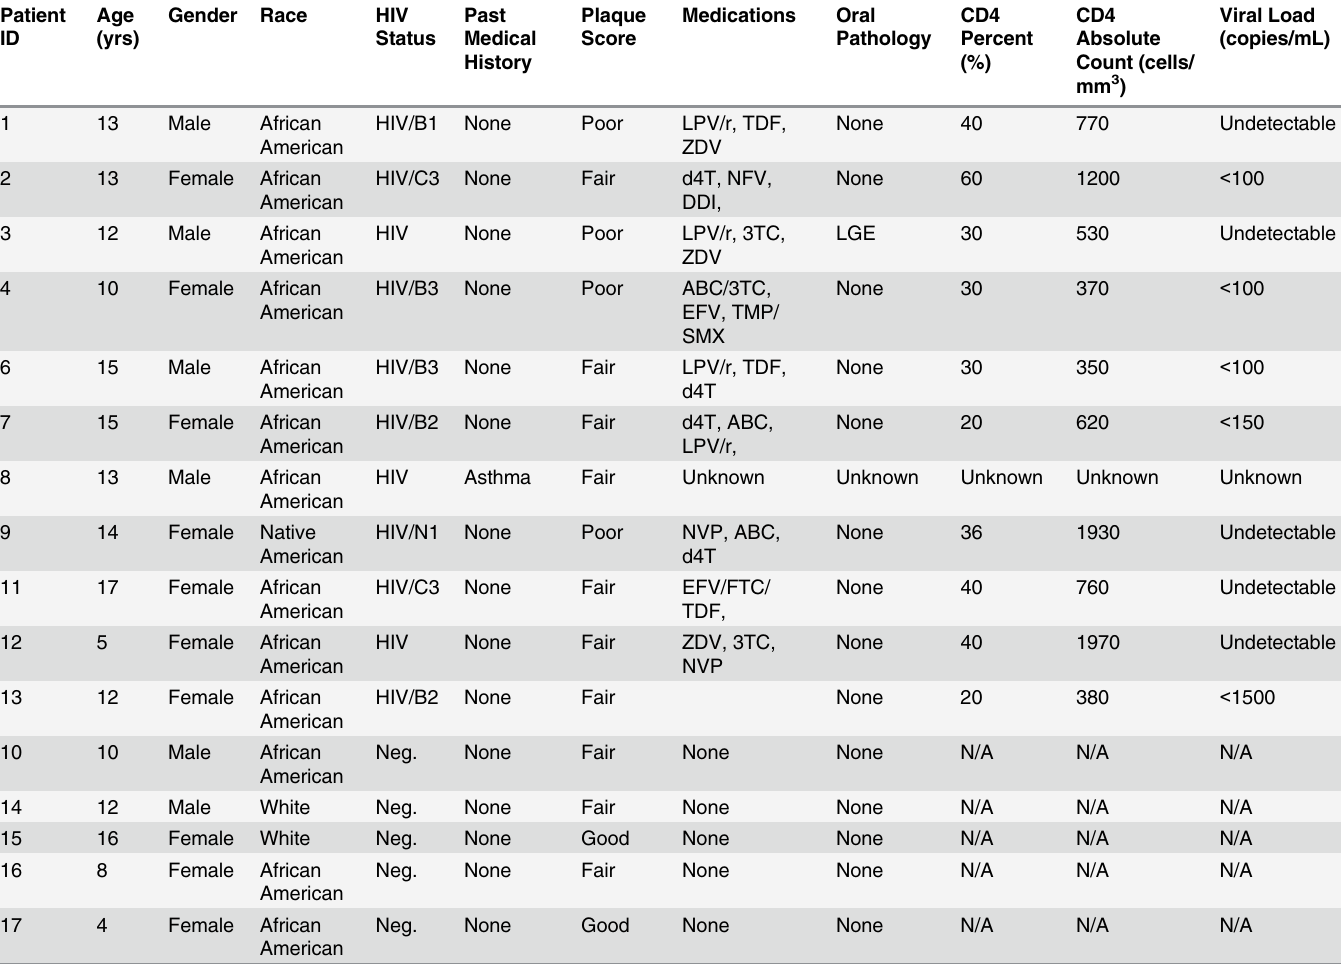
Table 1. Patient Demographics a .